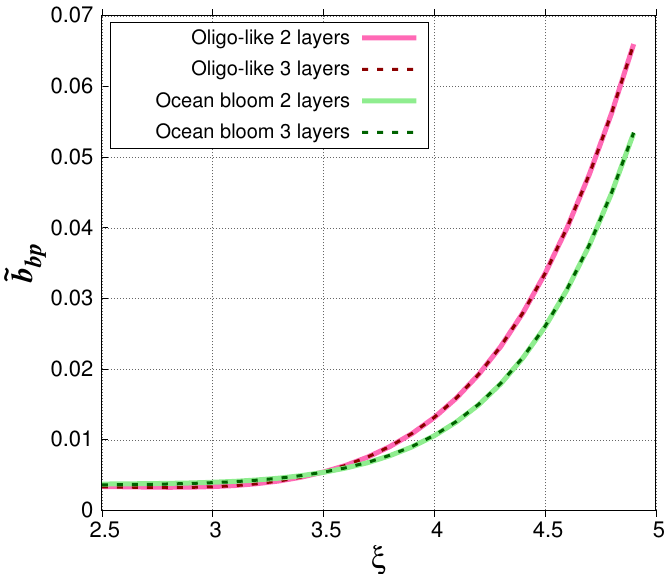
Figure 7. Particulate backscattering ratio as a function of the hyperbolic slope for oligotrophic-like and phytoplankton bloom water bodies. Phytoplankton cells are modeled as two-layered spheres (80%–20%) or three-layered spheres (80%–18.5%–1.5%), as